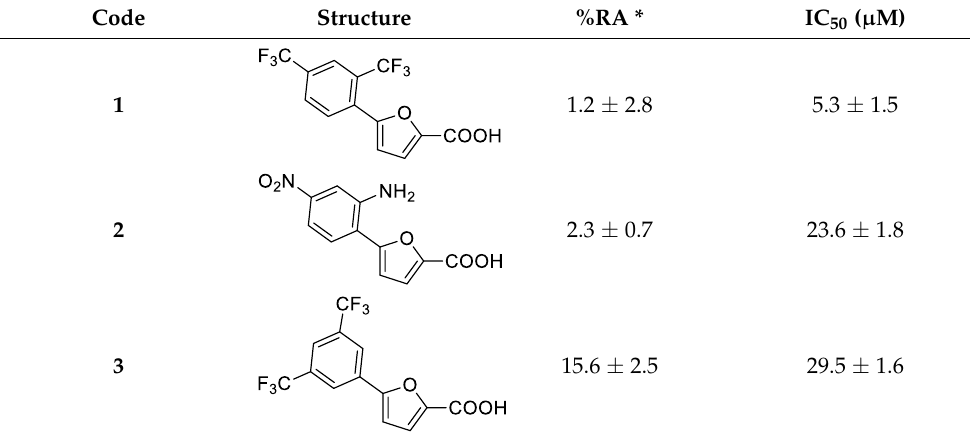
Table 1. In vitro inhibitory activities of compounds 1 – 3 against Mab -SaS.